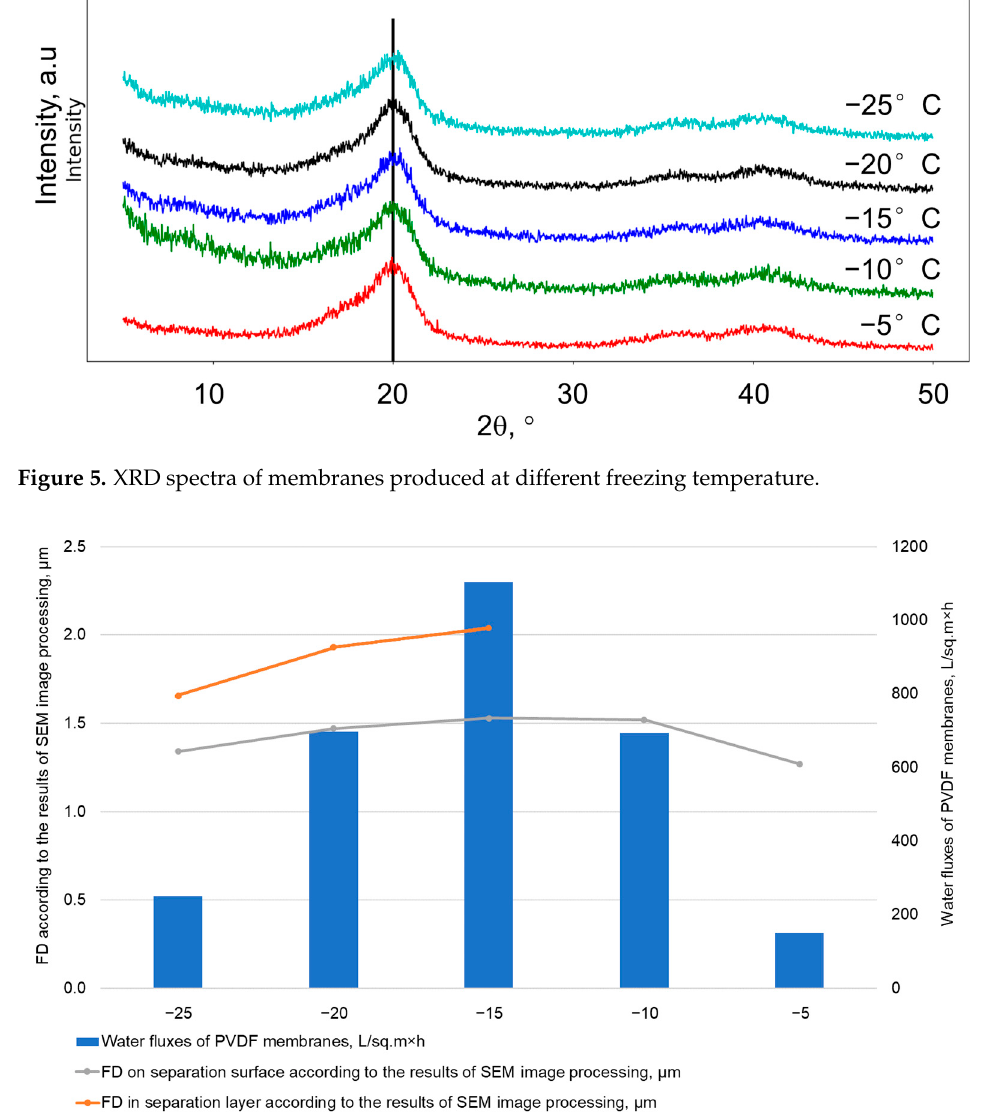
Figure 6. Figure 6. Water fluxes and FD according to the results of SEM image processing for the produced membranes.